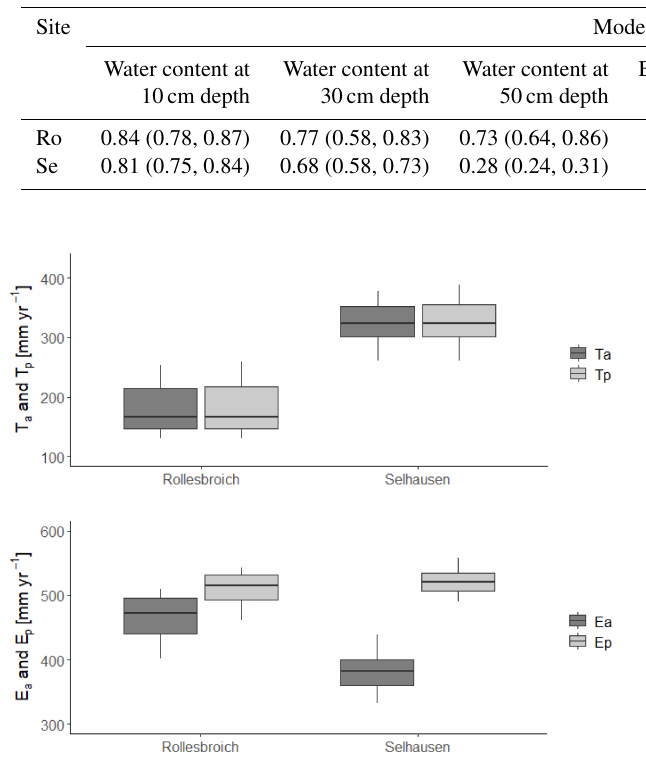
Table 6. Model efficiencies for the different data types (median values of the 30 acceptable parameter sets, with minimum and maximum values in parentheses).